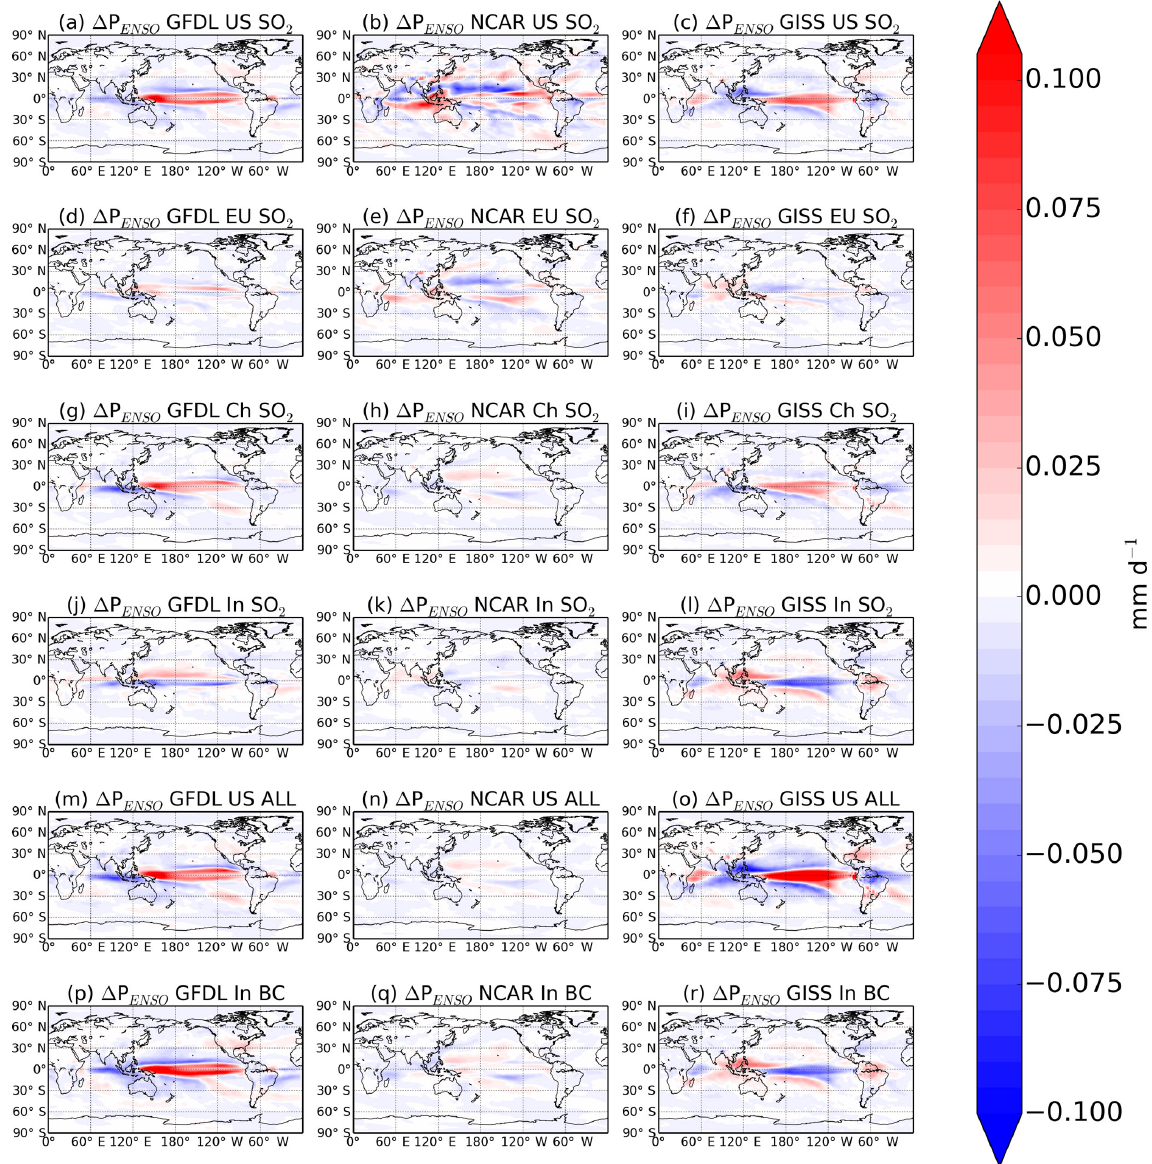
Figure 6. 200-year annual mean ENSO component of the precipitation response to aerosol emissions decreases in each of the three models (GFDL-CM3, first column; NCAR-CESM1, second column; GISS-E2, third column) for several different regional emissions decreases (simulations indicated in figure titles; see Table 1). See text for